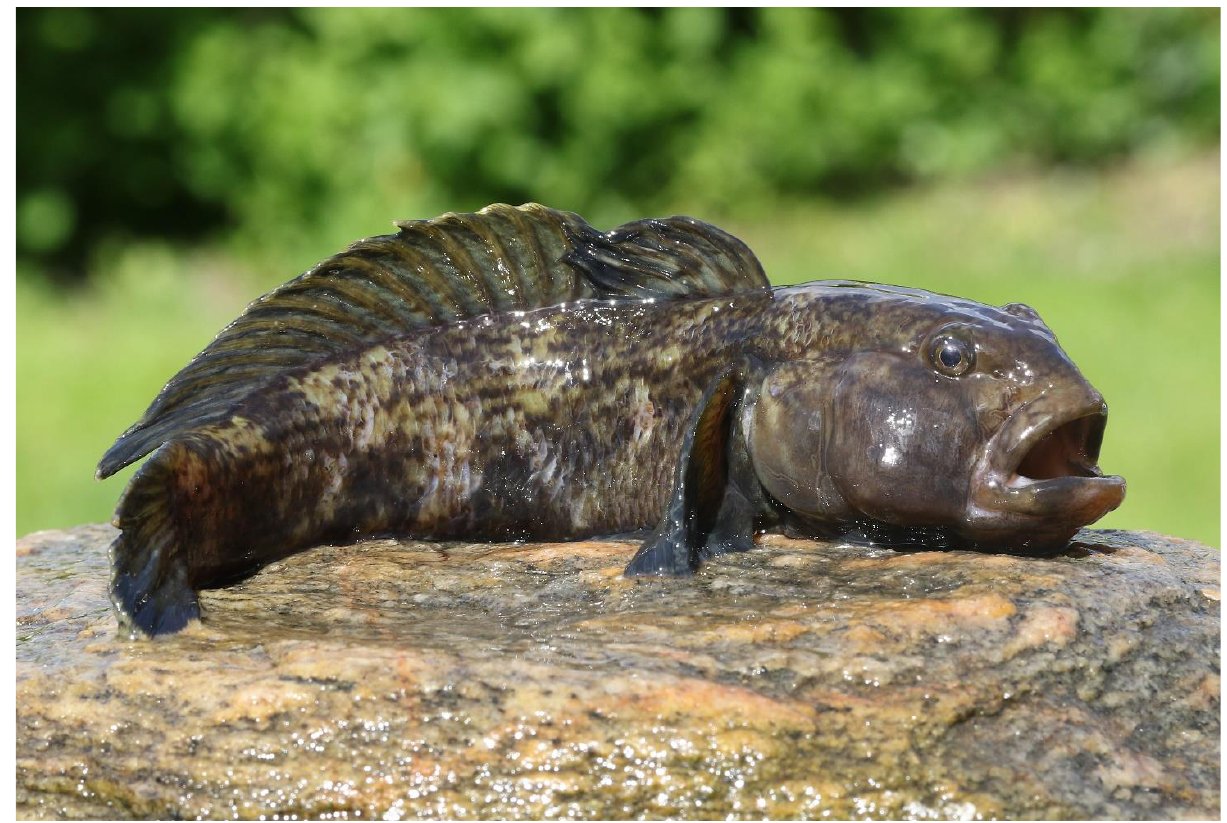
Figure 21. Neogobius melanostomus . Specimen from around Rødvig, May 2020. Length approx. 20 cm. Photo: H. Carl.